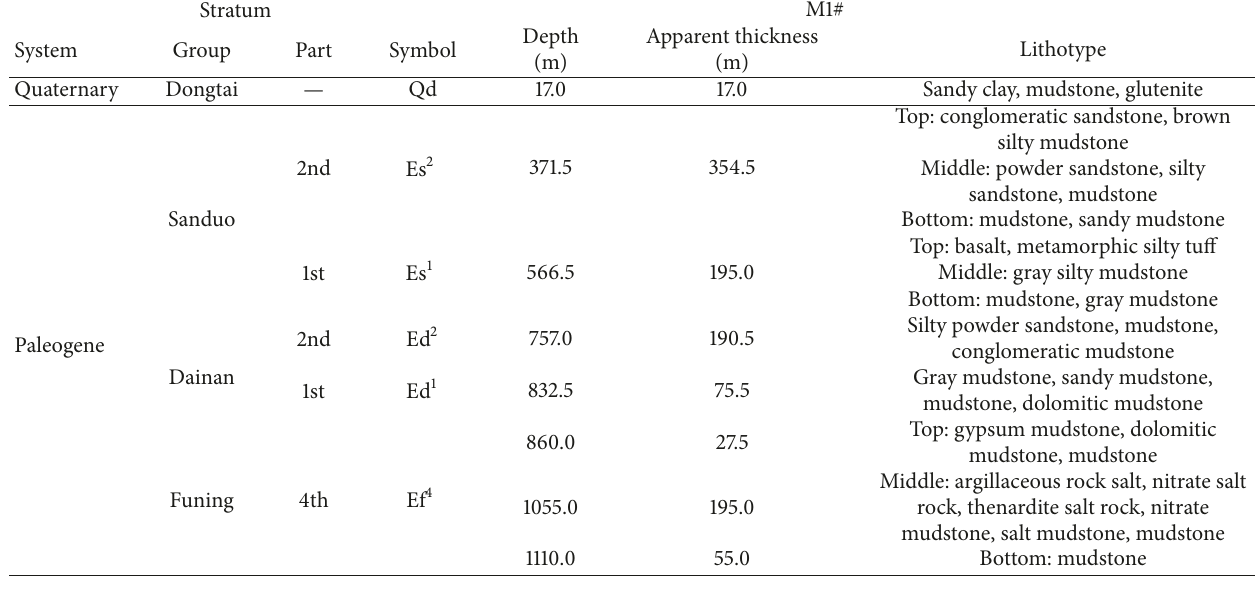
Table 1: Stratum information of Jintan salt mine.